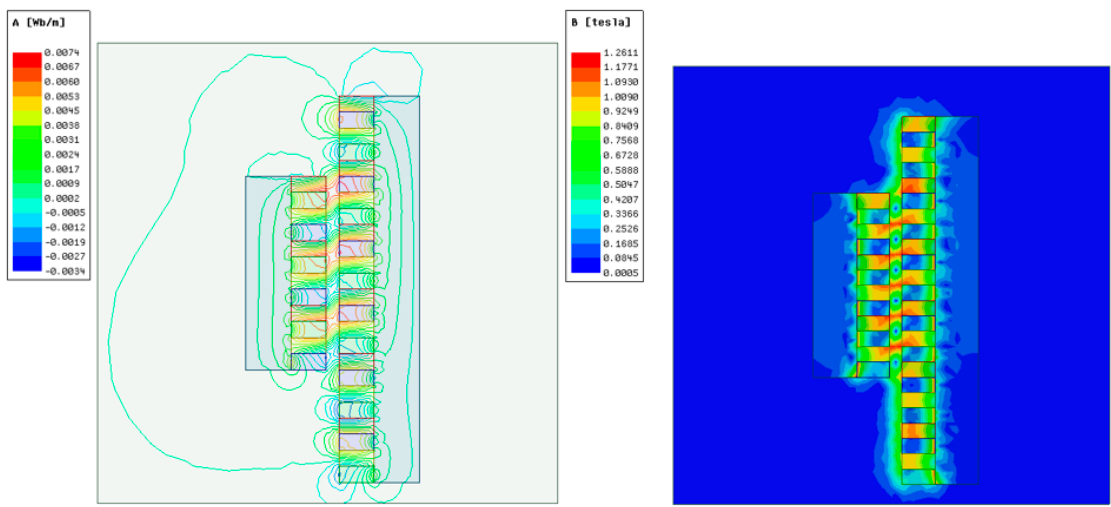
Figure 13. Magnetic field distribution and flux density on segmented magnet array-based MLA in 2D Cross-section.